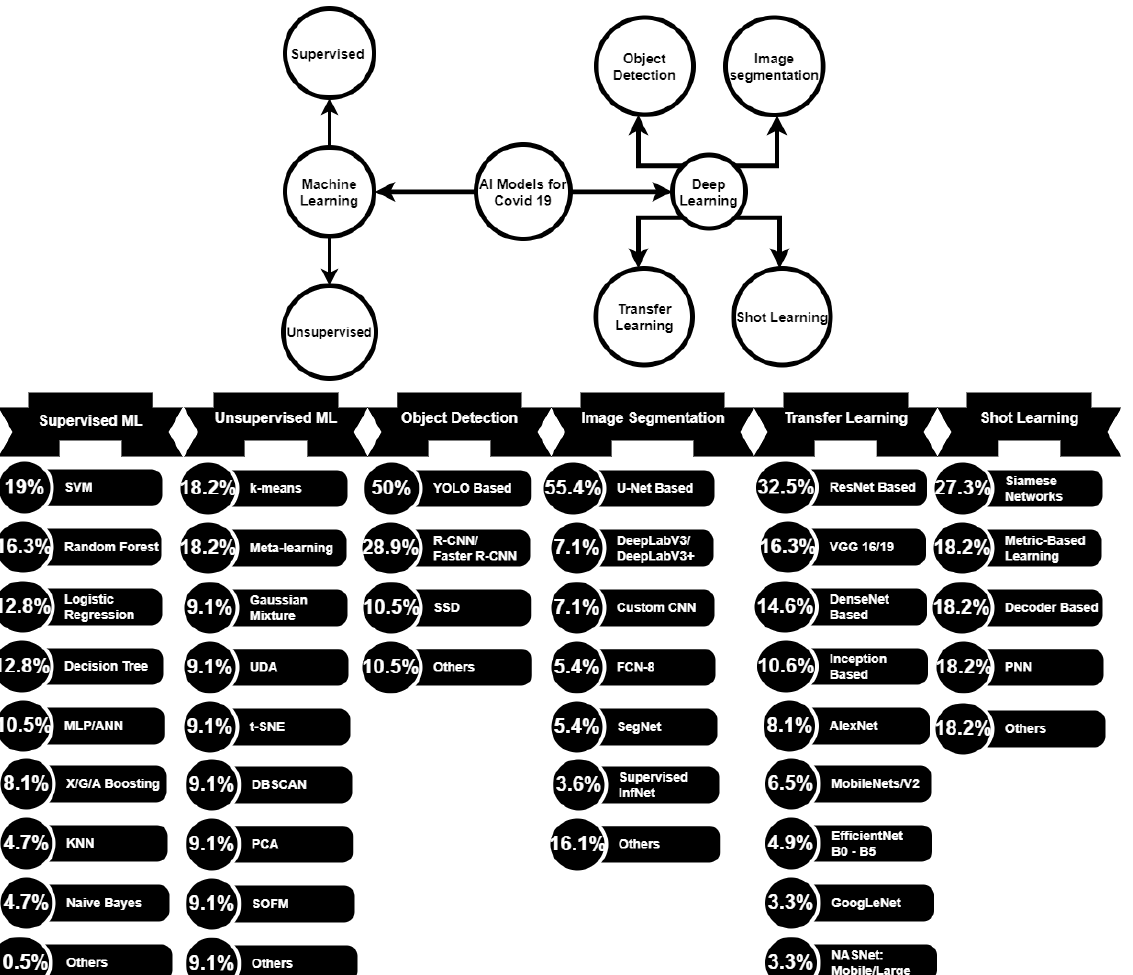
Figure 1. The infographic overview of AI approaches for COVID-19. The percentage indicates the use of AI models in diverse areas of